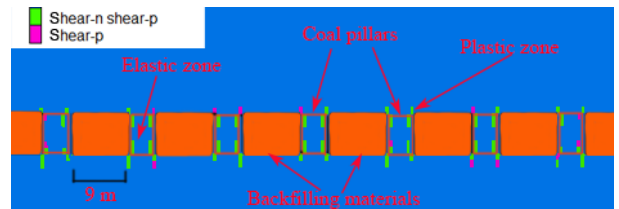
Figure 12. Plastic zone distribution for a 9m wide excavation road-